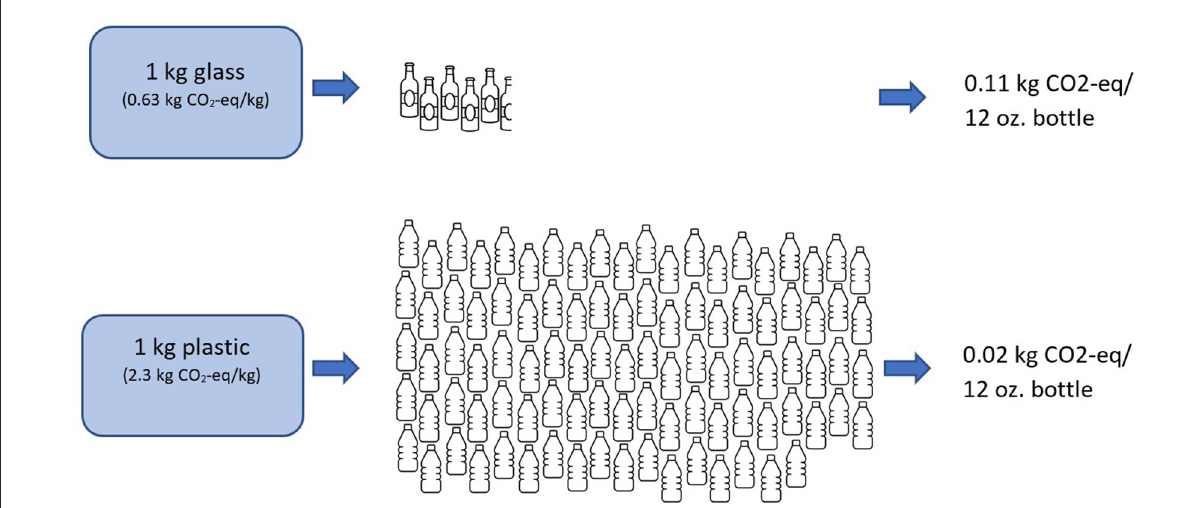
FIGURE1 1kg of glass and plastic to be used to produce 12 oz beverage containers, assumed to contain 10.3g of PET for plastic and 180g of glass and yielding 5.6 and 97 containers respectively. Assumes 2.3kg CO 2 -eq/kg PET and 0.63kg CO 2 -eq/kg glass.